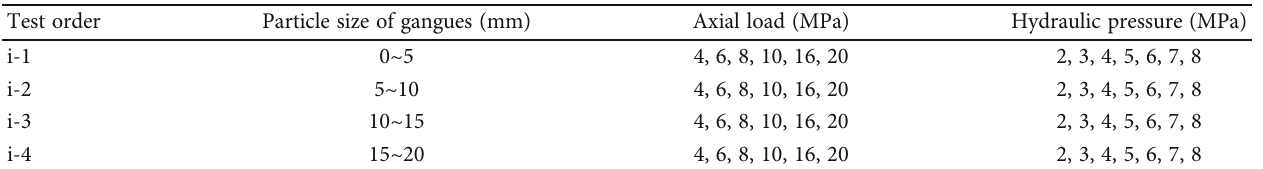
Figure 4: Illustration of the loading process of the permeameter. Table 1: Test